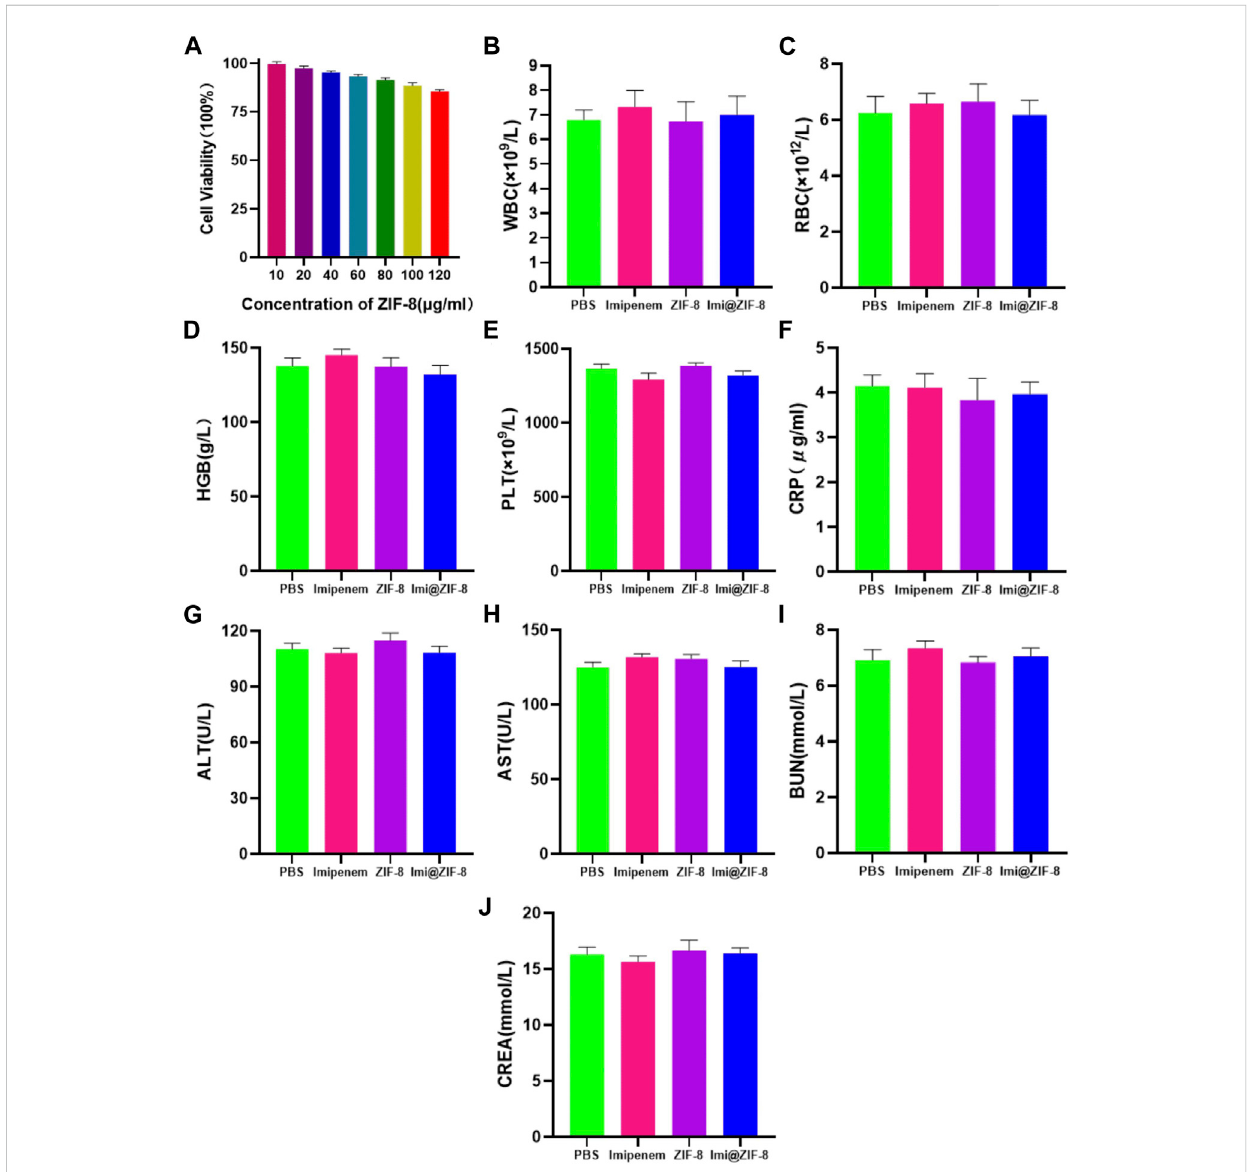
FIGURE 7 The toxicity assessment of Imi@ZIF-8. (A) MLE-12 cells was treated with various concentration of ZIF-8 for 24 h; the cell viability (%) was assayed by CCK-8. (B – J) Blood routine and blood biochemical indices of mice at 7 days after intraperitoneal injection of PBS, imipenem, ZIF-8 and Imi@ZIF-8. Data are indicated as means ± SD ( n =